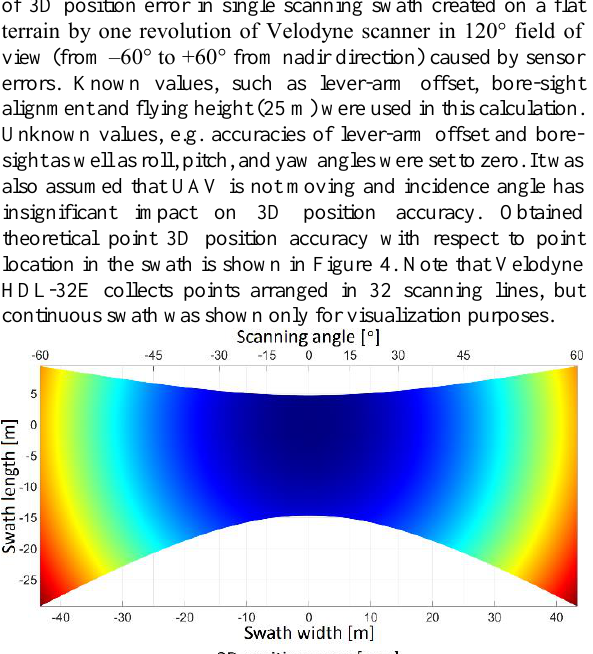
Figure 5. UAV position differences calculated between forward and reverse EKF solution.